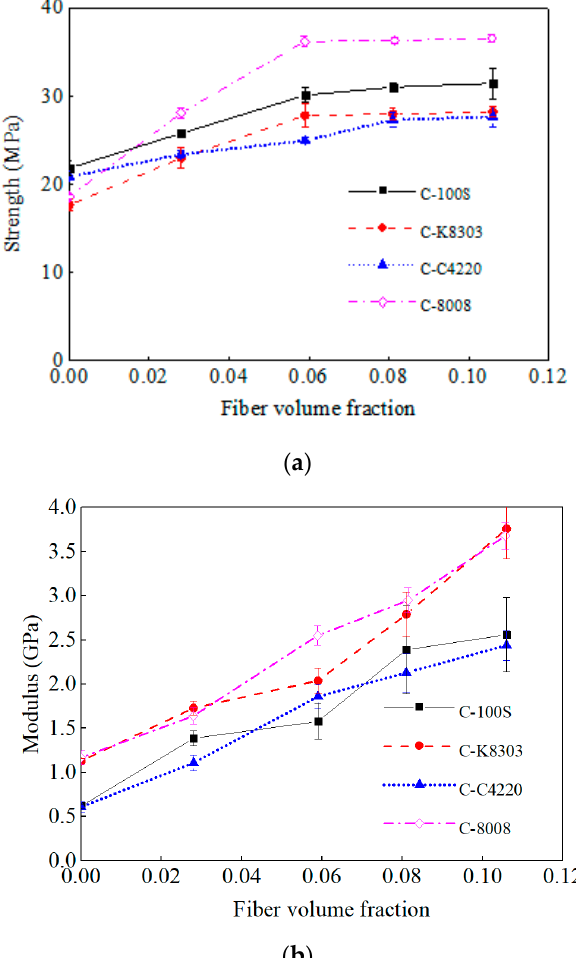
Figure 2. Tensile properties of the neat polymers and LFT composites. ( a ) tensile strength; ( b ) tensile modulus.